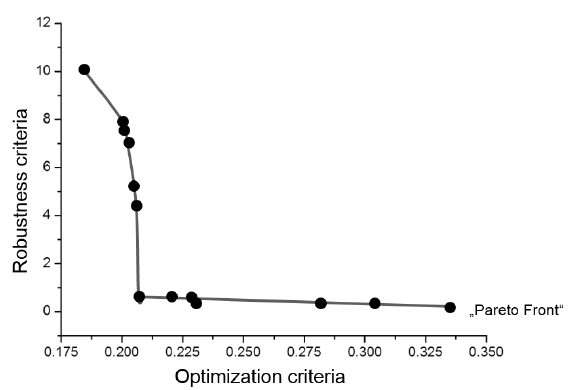
Fig. 3. Pareto Front as a result of a coupled Robust Design Optimization of a Cooke triplet. Two objective functions were used: one for the robustness criteria (here: weighted standard deviations of the merits) and a second one for the optimization criteria (here: weighted merits). Each design point on the front is a best design as a compromise between the two